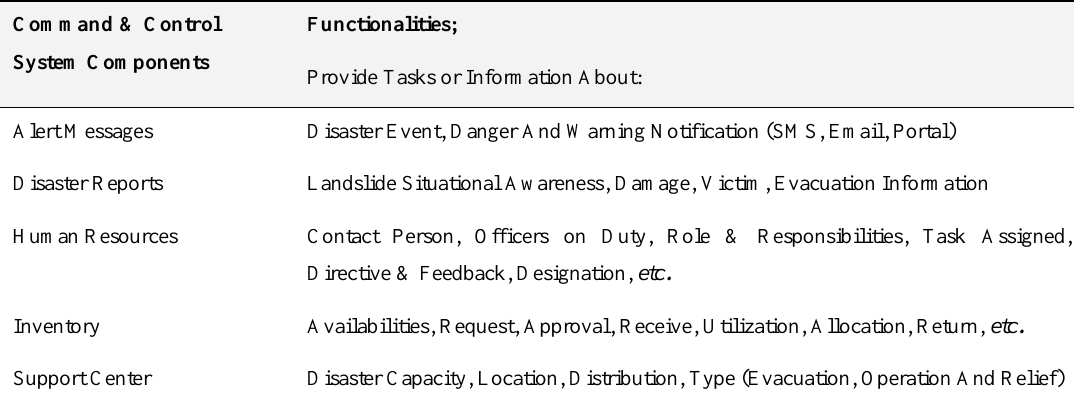
Table 3. Command & Control System Components and Functionalities.